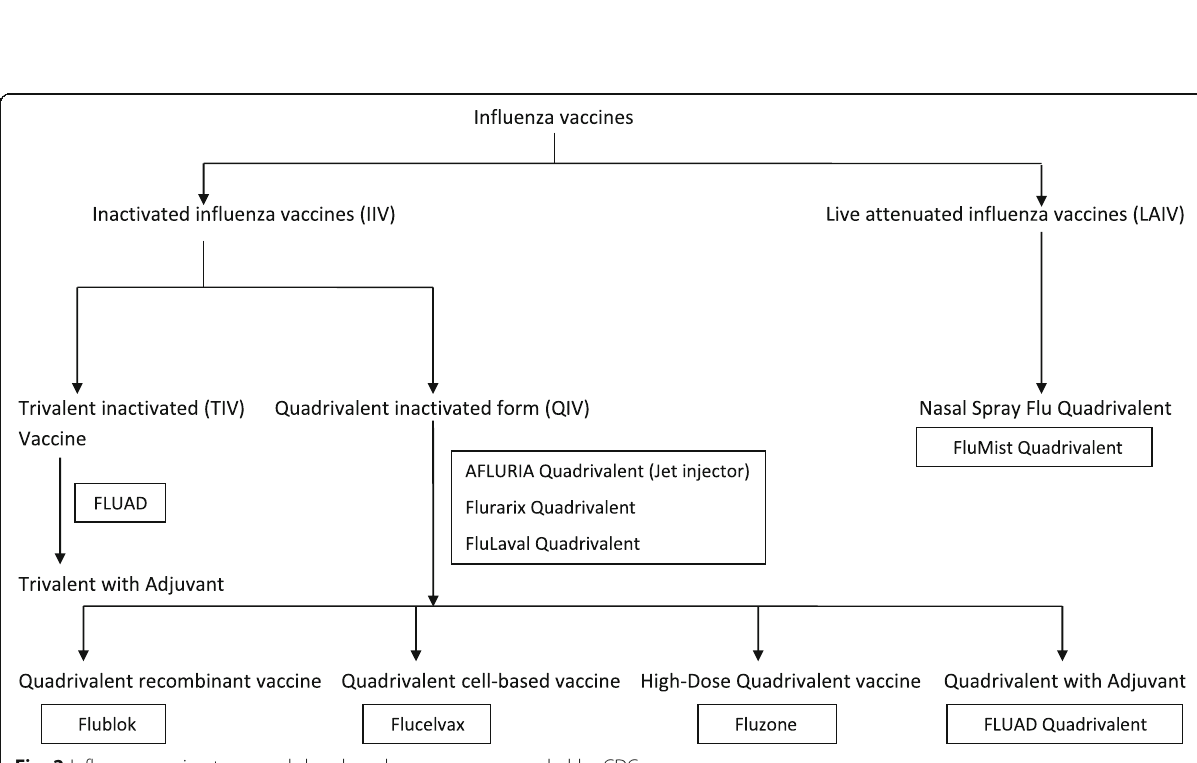
Fig. 2 Influenza vaccine types and drug brand names recommended by